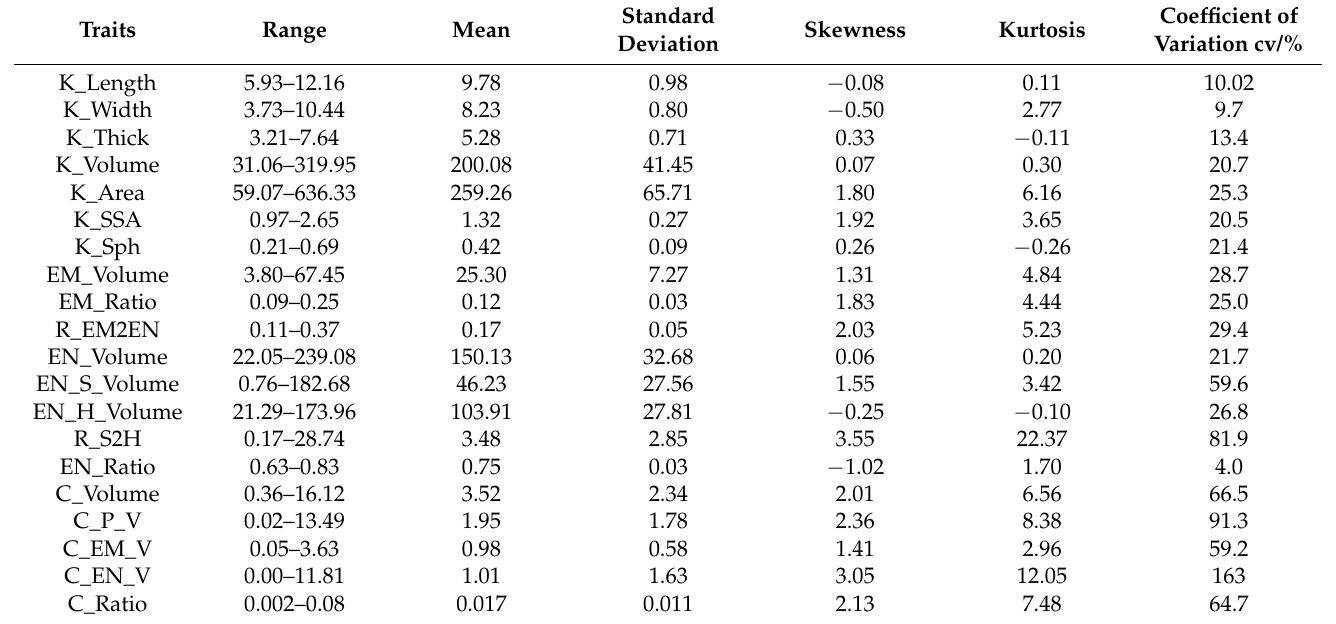
Table 2. Results of descriptive statistical analysis for kernel phenotypic